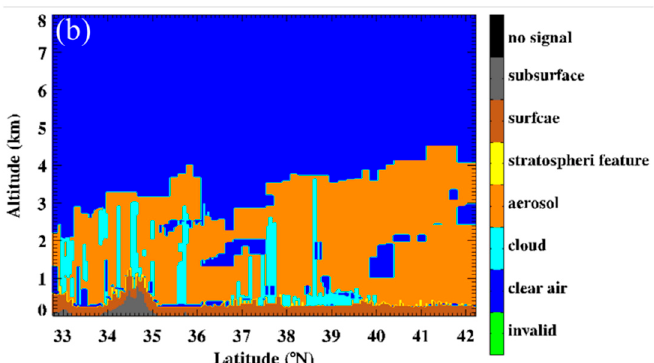
Figure 14. Sample image of ( a ) the fog detection result for the sea fog at 02:00 KST on 03 August 2019. Navy blue line represents the CALIPSO track and green points on the track indicate the fog pixels redefined from the VFM data. ( b ) VFM data of the track depicted ( a ) over the sea.